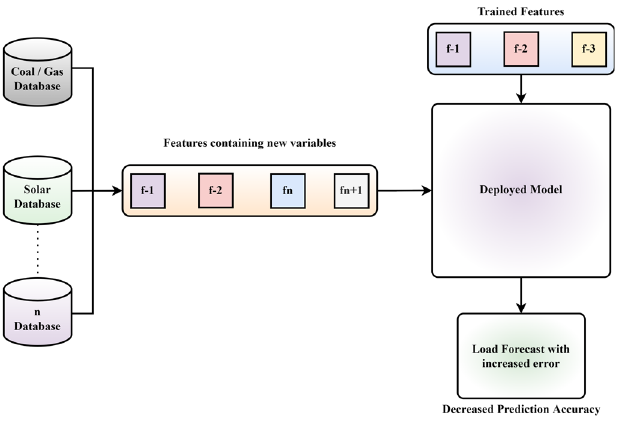
Figure 1. An illustrative example of deterioration in prediction accuracy of traditional models on introducing new